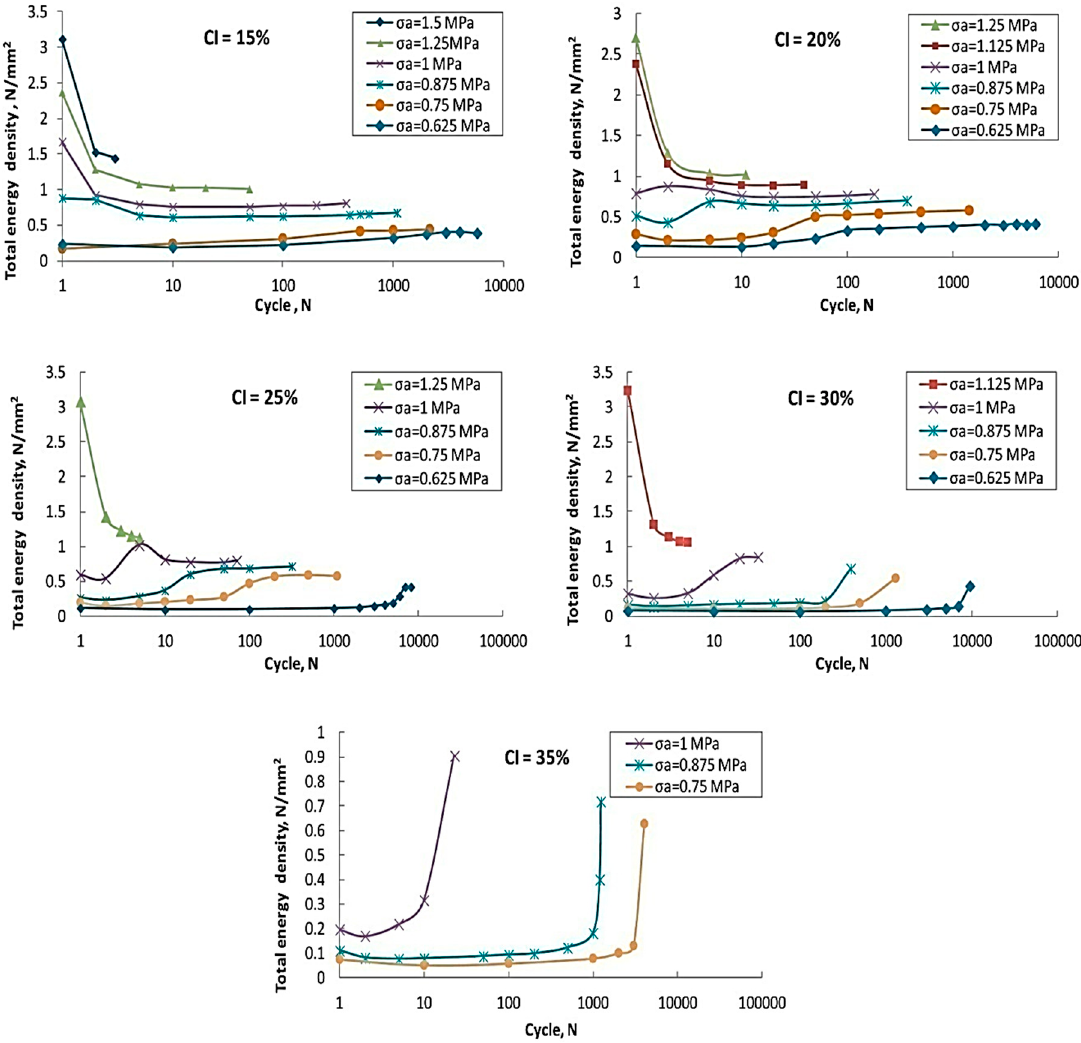
Figure 20. Plots of total energy density vs. cycles under different concentrations of CIPs [35] (reprinted with permission from Elsevier TM ).